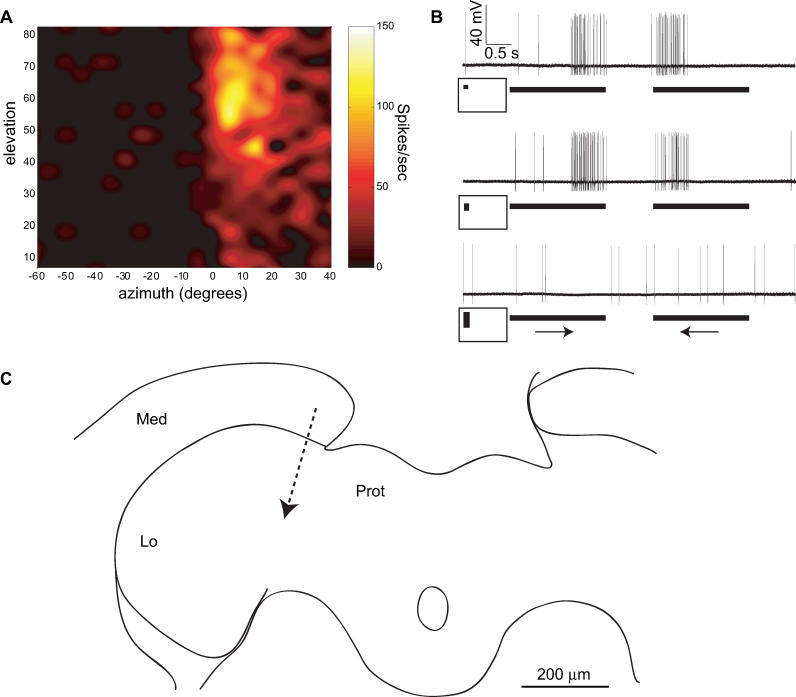
Physiology and Morphology of a Typical Class of Non-Directional STMD (Type 1) with a Large Contralateral Receptive Field, Recorded from the Left Lobula(A) The receptive field map constructed by drifting targets in four directions across the stimulus display (seeMaterials and Methods). Elevation values are positive above the equator, and azimuths are negative to the left of the midline (i.e., ipsilaterally).(B) Raw responses of the neuron to motion of three different-sized targets (0.8°, 3°, or 15° high by 0.8° wide) drifted through the center of the receptive field (horizontal scans at an elevation of 60°). The bars indicate the peri-stimulus duration and the arrows the direction of target motion.(C) The morphology of STMD 1 reconstructed from a Lucifer yellow fill shows extensive arborization through the lobula (Lo). A contralateral projection through the protocerebrum (Prot) probably provides the input. The arrow points to the recording location. Med, medulla.